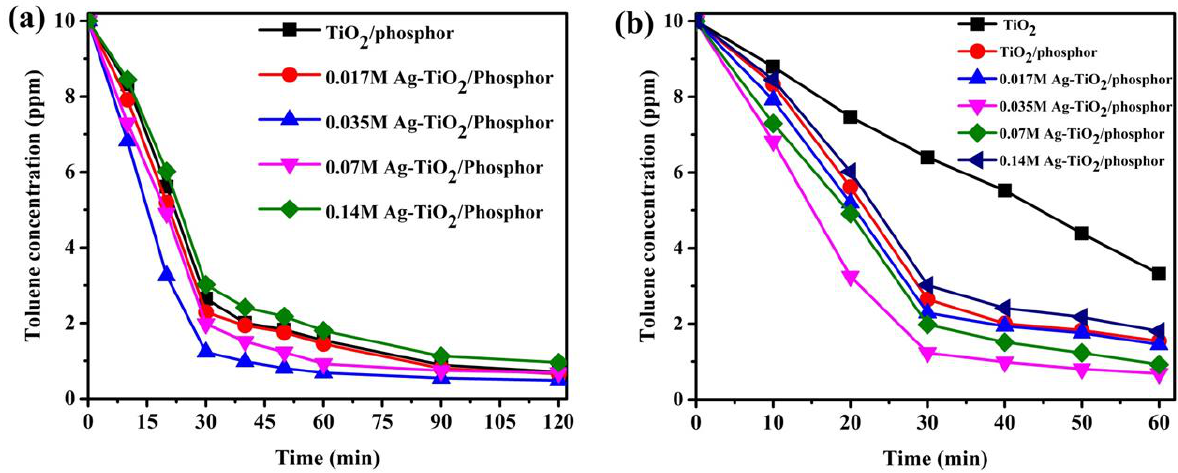
Figure 7. Photocatalytic degradation of toluene over Ag-TiO 2 /Sr 4 Al 14 O 25 :Eu 2+ ,Dy 3+ photocatalyst/phosphor beads under UV light activation.